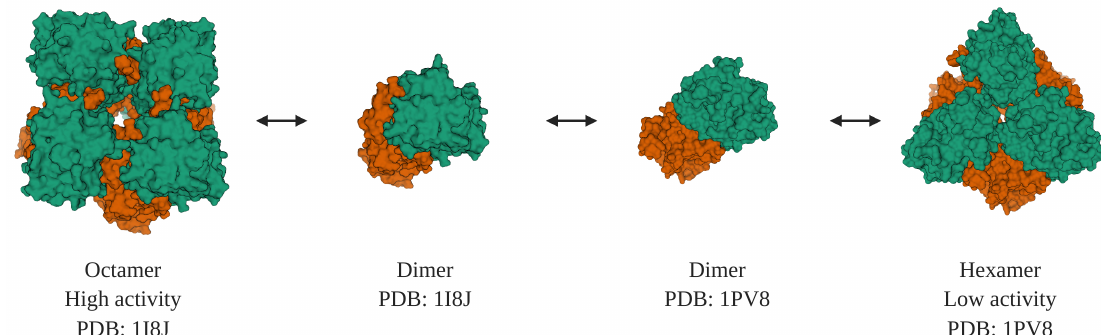
Figure 4. Structures of porphobilinogen synthase, which is both a morpheein and a moonlighting protein. Porphobilinogen synthase can form two homo-multimers, a low activity hexamer (PDB